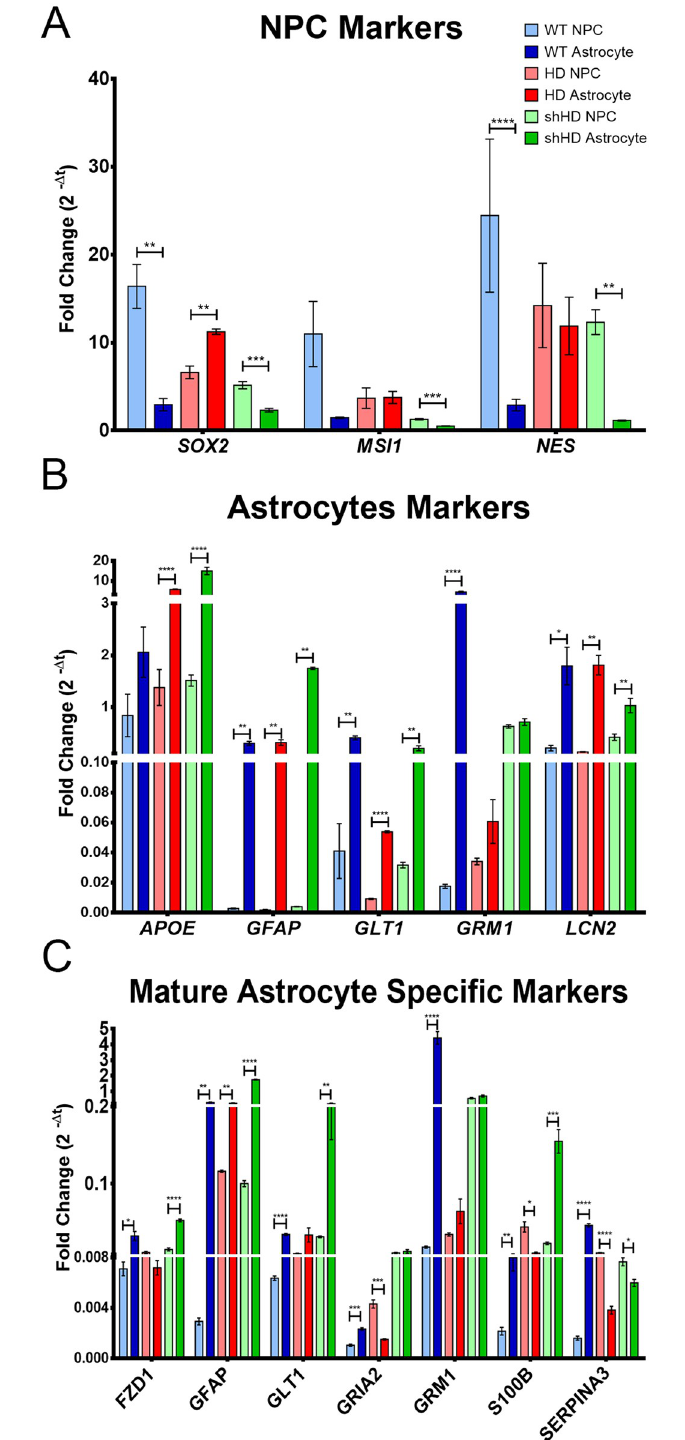
Fig 3. Gene expression profile of before and after astrocyte differentiation (day 30). (A) Before and after gene expression of NPC specific markers: SOX2 , MSI1 , and NES . WT and shHD showed a significant decrease in SOX2 and NES expression. shHD showed a significant decrease in MSI1 expression. (B) Before and after gene expression of astrocyte-specific markers: APOE , GFAP , GLT1 , GRM1 , and LCN2 . All three cell lines showed a significant increase in GFAP , GLT1 , and LNC2 expression. HD and shHD showed a significant increase in APOE expression while only